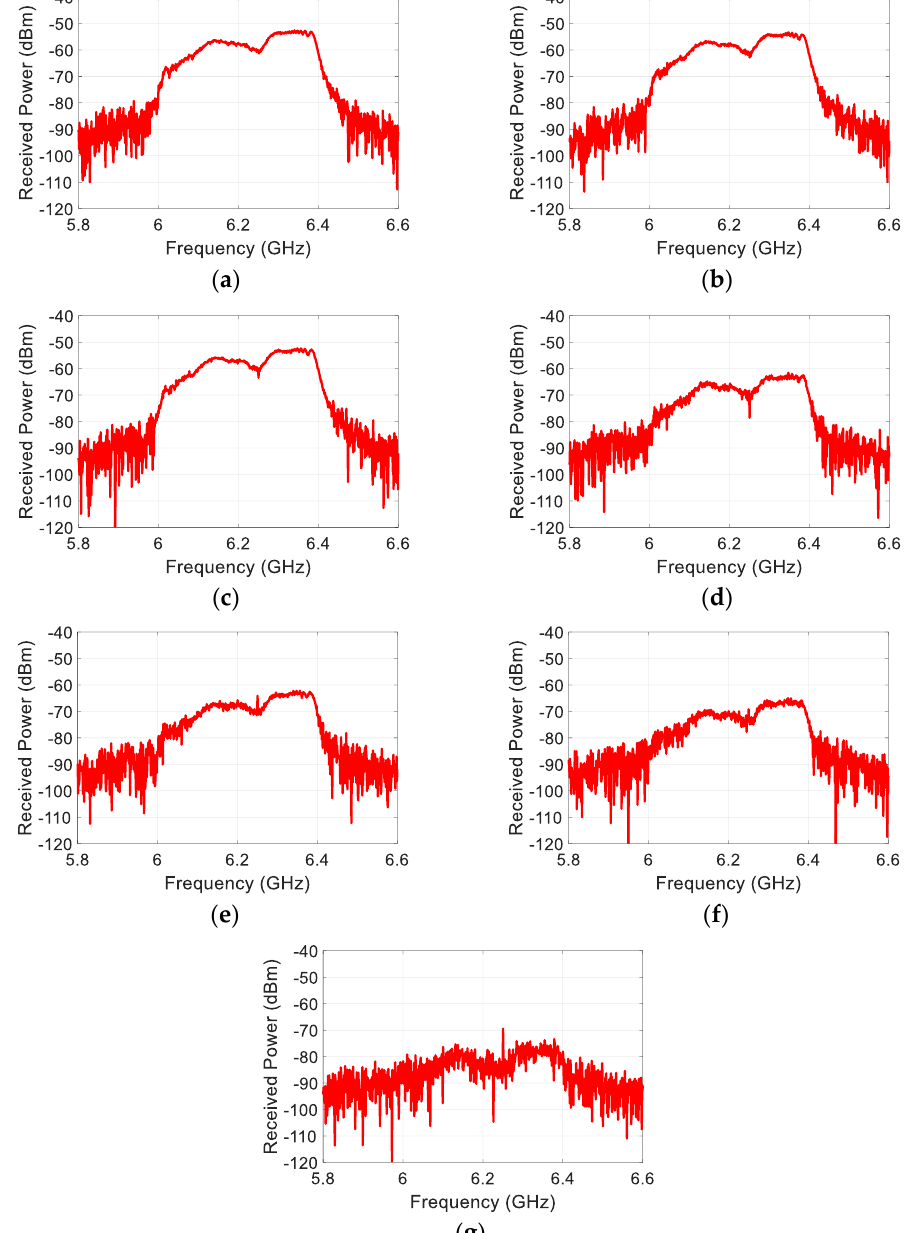
Figure 8. Amplitude spectrum of the measured target responses. ( a ) laptop, ( b ) tablet PC 2, ( c ) tablet PC 1, ( d ) cell phone, ( e ) diode-terminated antenna, ( f ) radio 2, ( g ) radio 1.